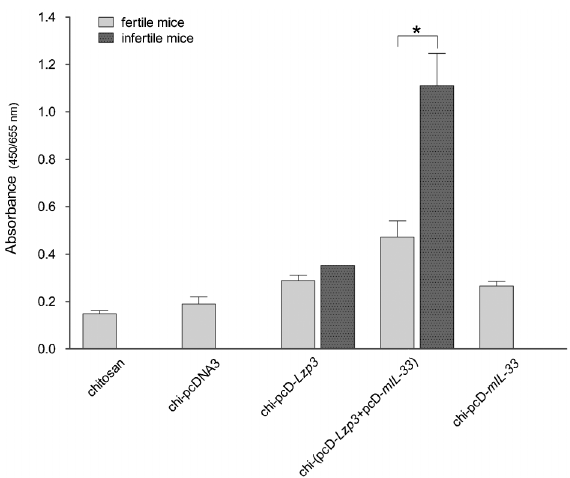
Figure 5. Anti-LZP3 IgG levels in serum of fertile and infertile mice. Anti-LZP3 IgG levels in serum of fertile and infertile mice (n=8/group) were detected by ELISA on day 56 after the 1st immunization. *P , 0.01, IgG levels in infertile mice co-immunized with chi-(pcD- Lzp3 +pcD- mIL -33) compared to fertile mice (one- sided Student t